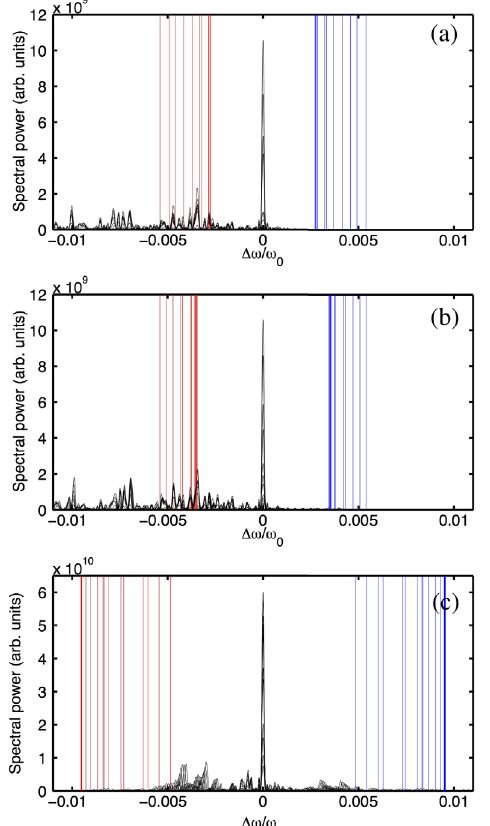
FIG. 5. FEL output spectra for (a) untapered, (b) 0.8%-tapered, and (c) 10%-tapered cases. Each of the spectra are overlapped at several equal-distance z locations. The thin red and blue lines denote the lower and upper sampling synchrotron sideband frequencies, respectively. The thick red and blue lines indicate the final synchrotron sideband frequency sampled at the undu- lator exit.